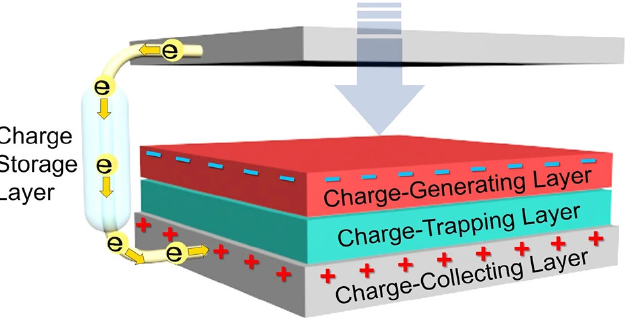
Figure 4. Sketch of main components of a triboelectric nano-generator, including the charge-generating layer, the charge-trapping layer, the charge-collecting layer, as well as the charge-storage layer. Reproduced with permission [109] . Copyright 2020, Springer Nature.